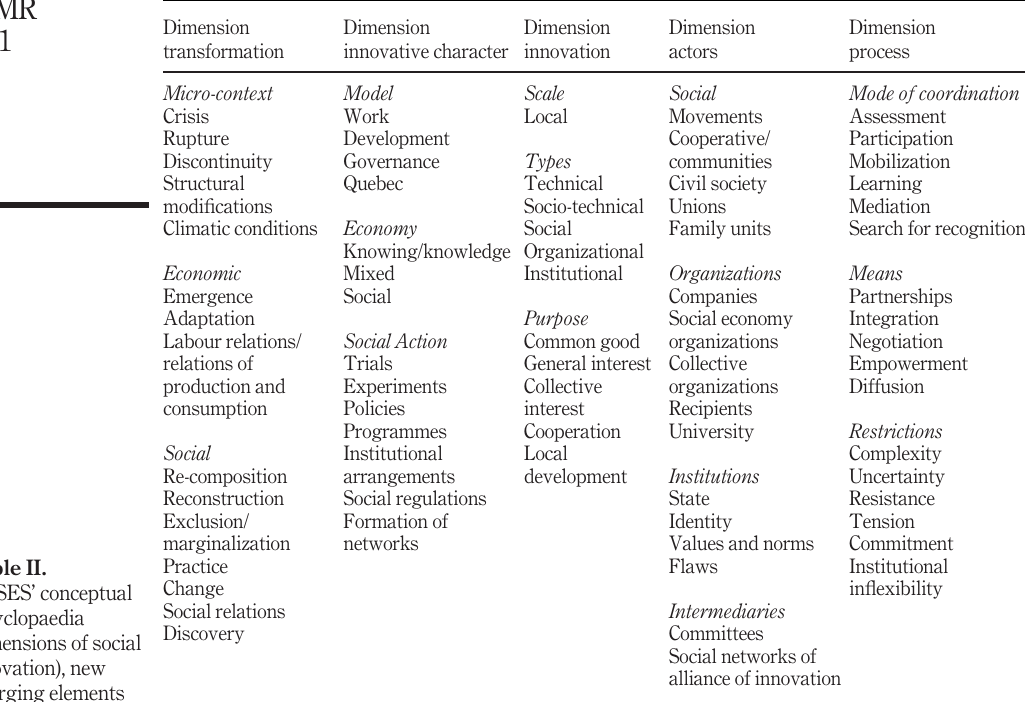
Table II. CRISES ’ conceptual encyclopaedia (dimensions of social innovation), new emerging elements were added after ADEL ’ s case